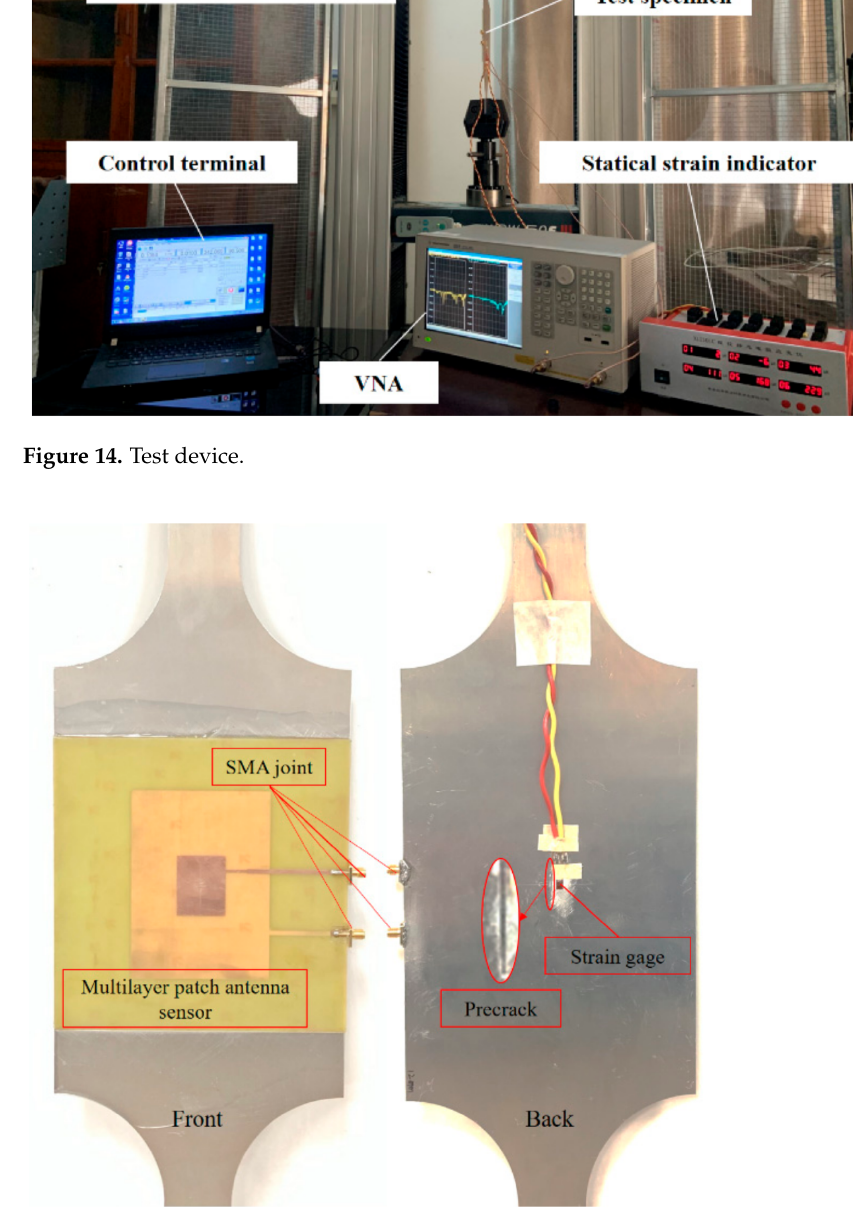
Figure 15. Arrangement of the test sample. To reduce test errors, measurements were taken three times at each crack length level, and the resonant frequency information from the lower crack test patch and the upper strain test patch was measured simultaneously during the crack growth process. To provide further observations of the resonant frequency variations in the upper strain test patch during crack propagation, the rate of resonant frequency change of the upper patch was normalized, and the test results are shown in Figure